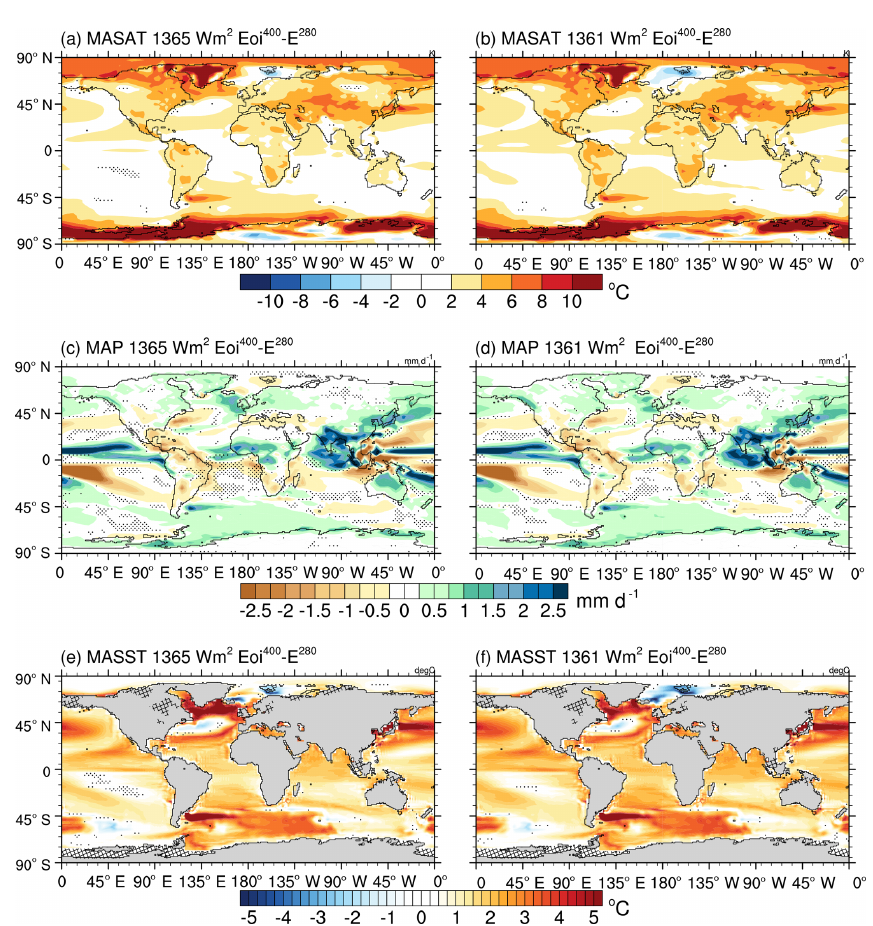
Figure 15. Sensitivity of Eoi 400 –E 280 anomalies on TSI values for (a, b) MASAT, (c, d) MAP and (e, f) MASST. Stippling indicates regions in which results are not statistically significant at a 95% confidence